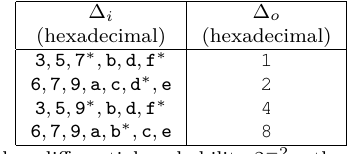
Table 4: Differential transition of PRESENT Sbox where HW (∆ o ) = 1. ∆ i ∆ o (hexadecimal) (hexadecimal) 3 , 5 , 7 ∗ , b , d , f ∗ 1 6 , 7 , 9 , a , c , d ∗ , e 2 3 , 5 , 9 ∗ , b , d , f ∗ 4 6 , 7 , 9 , a , b ∗ , c , e 8 ∆ i with ∗ has differential probability 2 − 2 , otherwise 2 − 3